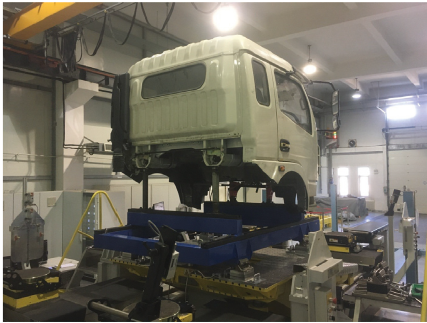
Figure 1: Overall measurement of cab and mounting seat.